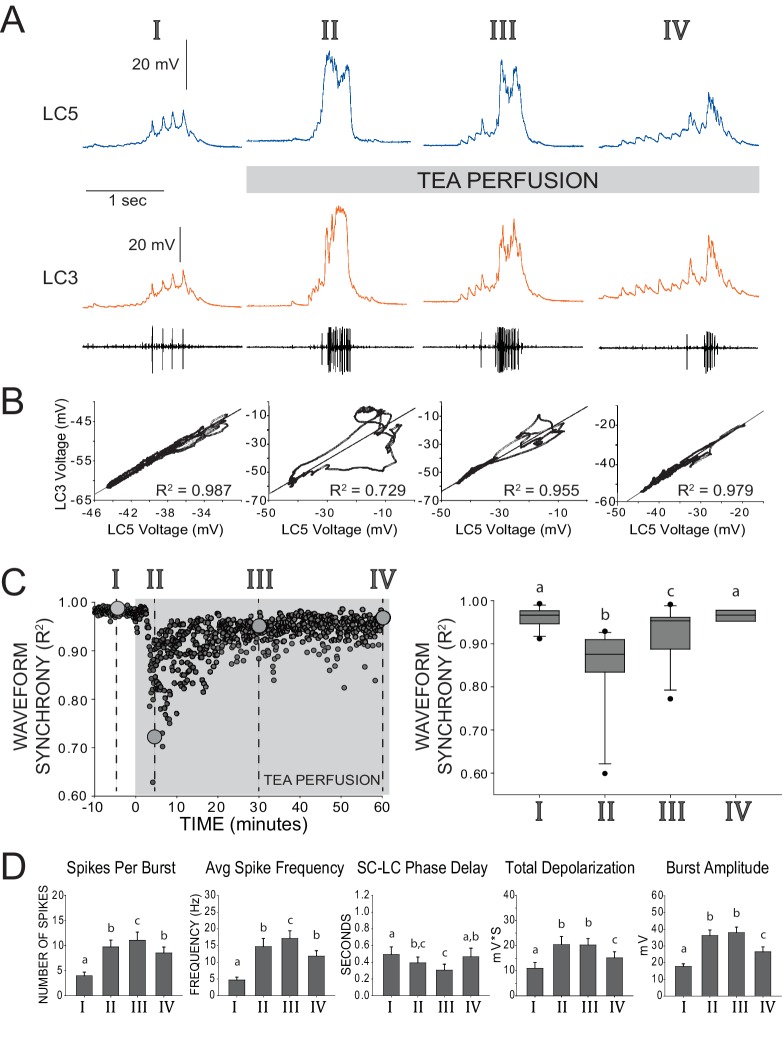
Restored excitability and waveform synchrony among LCs after 1 hr of TEA exposure.(A) Representative recordings of LC3 and LC5 and of network activity over one hour of TEA exposure. Roman numerals (I, II, III, IV) designate time points of reference throughout the remainder of the figure, as follows: I – control saline, II – acute TEA exposure identified as the maximum effect on loss of synchrony across LCs (i.e. lowest R2 value), III – 30 min of TEA exposure, IV – 60 min of TEA exposure. (B) Scatterplots show pairwise correlation of time-matched voltages (sampled at 10 kHz) of the waveforms shown in the representative traces. R2 values are calculated from Pearson’s correlation tests for these two cells. Loss and restoration of conserved output is demonstrated by changes in coherence in the scatterplot as well as in R2 value. (C) Synchrony of waveforms of the two cells seen in panels A and B plotted as R2 values over the entire time course of the experiment. Roman numerals and large gray circles represent the values that were obtained from the scatterplots as each time point shown in panel B. TEA perfusion persists from time zero through 60 min. Box plots show distributions of R2 values from cross-correlation analyses of LC voltage waveforms for pairs of LCs from N = 11 preparations. Lines within boxes mark the median, box boundaries represent 25th and 75th percentiles, whiskers represent 5th and 95th percentiles, and points represent outlying observations. Groups with significant differences in median synchrony (p<0.05; Wilcoxon signed rank tests) are denoted with different letters. (D) Excitability of LCs was quantified by five measurements (mean ± SD). Analysis of each preparation used the average of 10 consecutive bursts at each time point (N = 8 preparations). Number of spikes per burst, spike frequency within each burst, and the latency between pacemaker firing and first motor neuron spike (SC-LC Phase Delay) were calculated from extracellular traces. Total depolarization and amplitude of each burst are based on intracellular recordings. Significant differences across groups (p<0.05; paired t-tests) are denoted with different letters, such that any two bars with a letter in common are not significantly different.